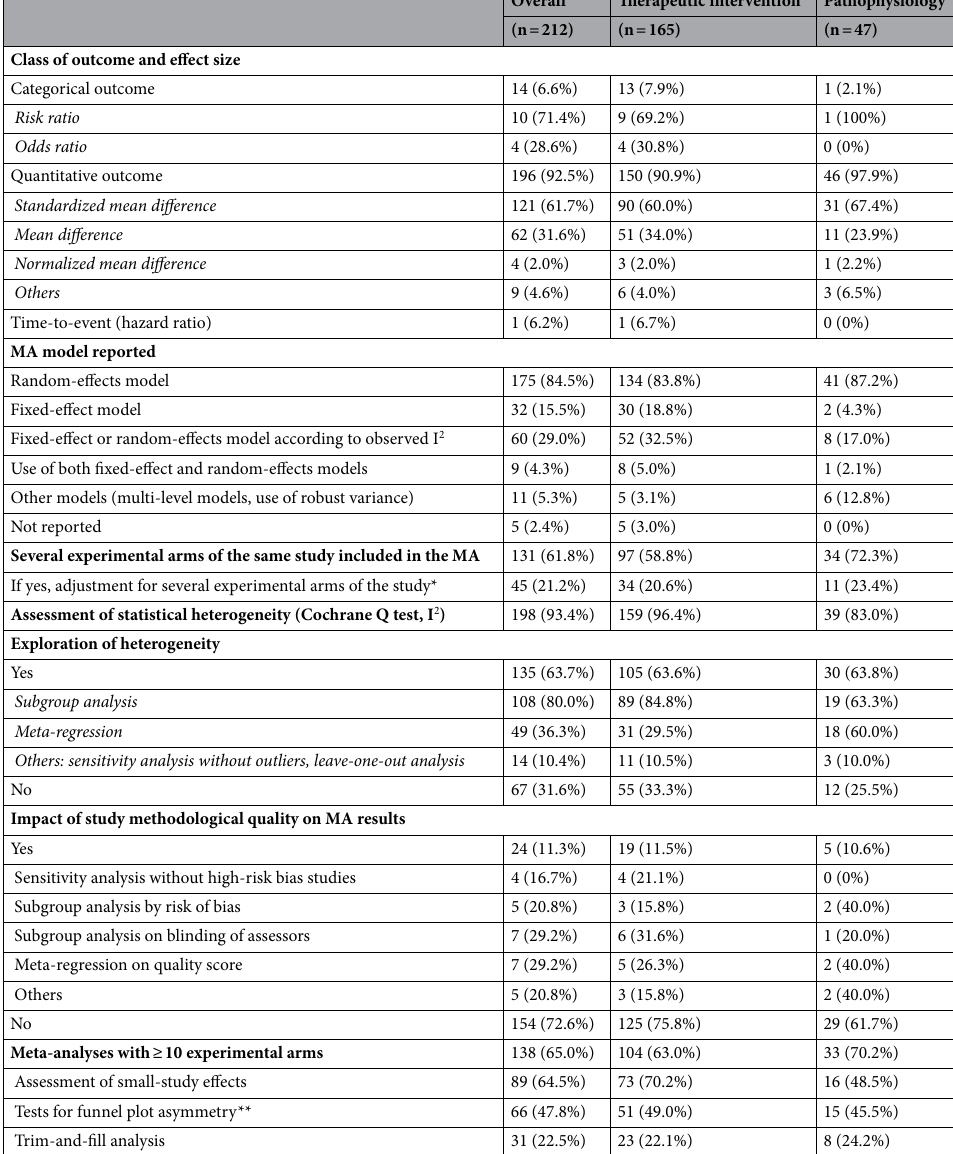
Table 3. Methodological characteristics of the meta-analyses (for the primary outcome or first reported outcome). MA meta-analysis. *Splitting the control group according to the number of experimental arms, use of robust variance in meta-analysis model, multi-level random-effects models. **Egger’s or Begg’s tests, other